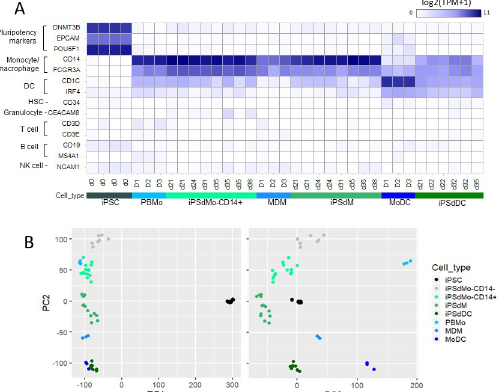
Fig 3. Differentiation of iPSC into monocytes and derivatives results in loss of pluripotent markers and concomitant up regulation of lineage markers associated with differentiated cell types. (A) Expression of lineage specific marker genes across all cell types., HSC; haematopoietic stem cell, NK cell; natural killer cell. Each column represents an individual sample and are grouped into cell type as shown. For the blood derived samples the sample has a donor designation (D1-3) for the IPSC-derived samples the sample has a designation that refers to the harvest day (Fig 1A). (B) Principal component analysis of all cells types generated in this study. PC1 v PC2 left panel, PC3 v PC2, right panel. Plots based on all